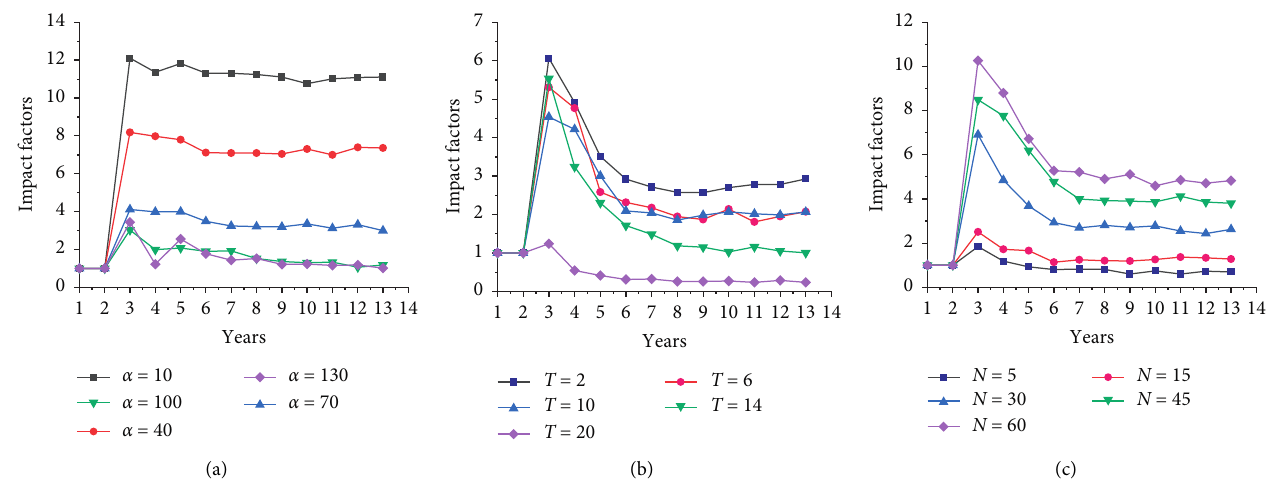
Figure 9: Correlation between impact factors and parameters α , T , and N : (a) β � 30; (b) α N ( baseline ) T � 10. ( baseline )